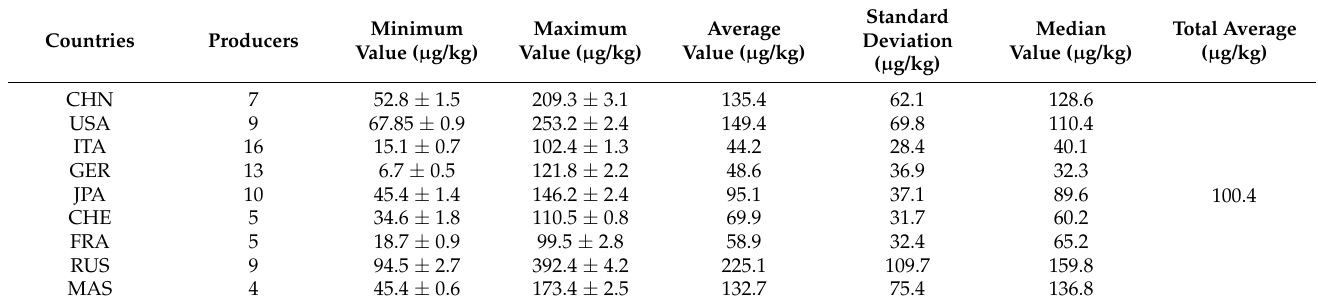
Table 1. Cd presence in chocolate samples measured by the ETV-AAS method ( n = 3).